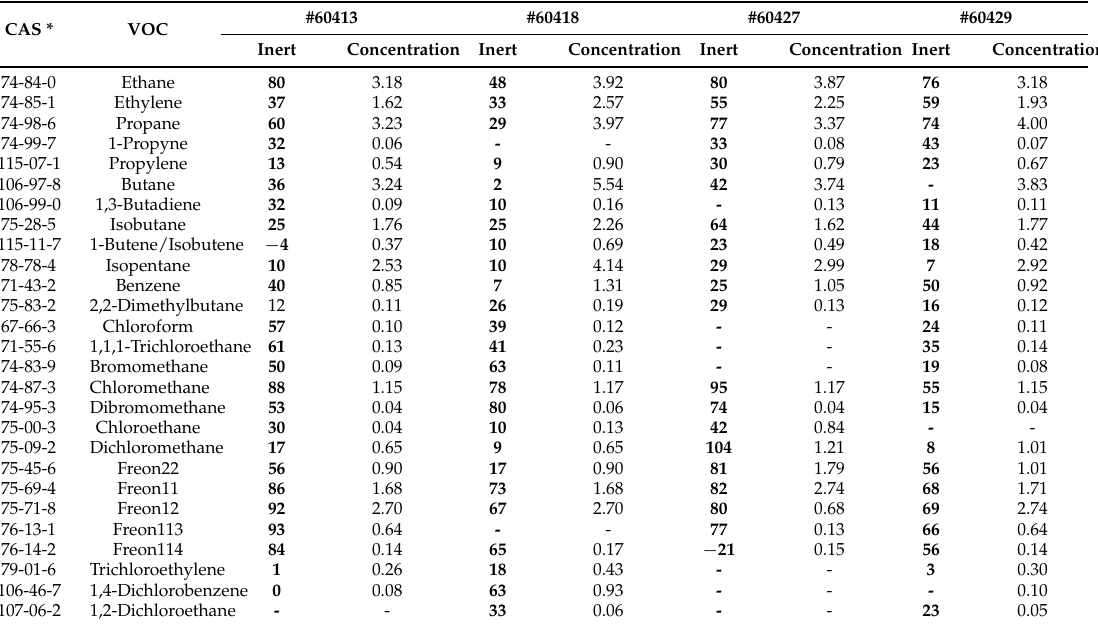
Table 2. Profiles of the “inert source” at the four monitoring stations in